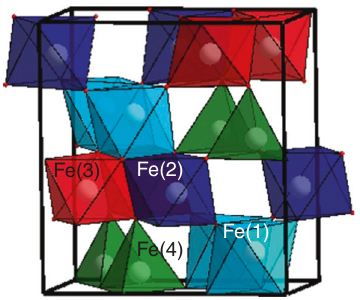
Fig. 1 Scheme of ε -Fe 2 O 3 structure. Polyhedral distribution of the ε -Fe 2 O 3 structure obtained by theoretical simulations. Fe(1)O 6 unit is plotted in light